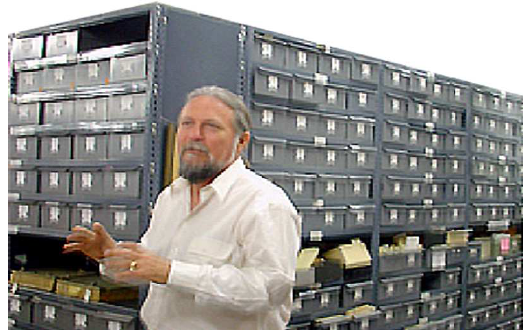
Figure 5. Inside the Keystone-Mast Collection, carrying